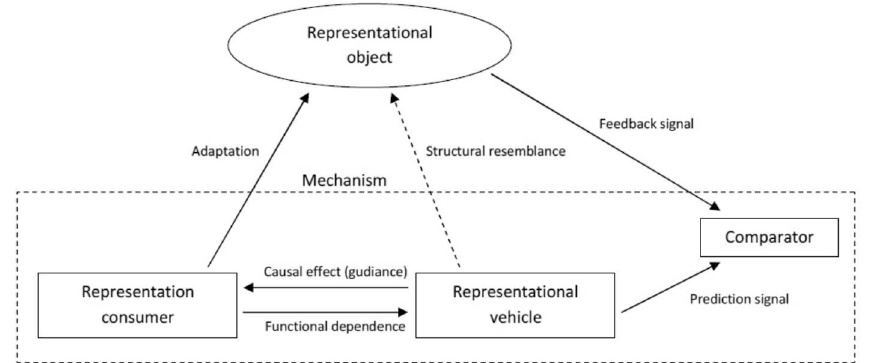
Figure 2. A schematic diagram of a representational mechanism equipped with a predict-and-compare system for representational error detection (see main text for